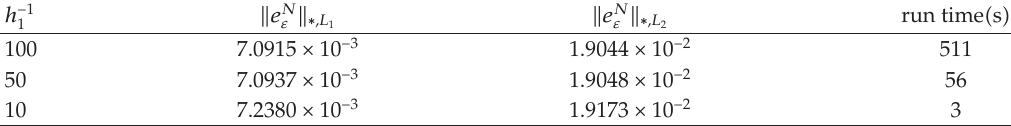
Table 5: Comparison of the micro-model to the macro-model as in Example 3.6. h − 1 1